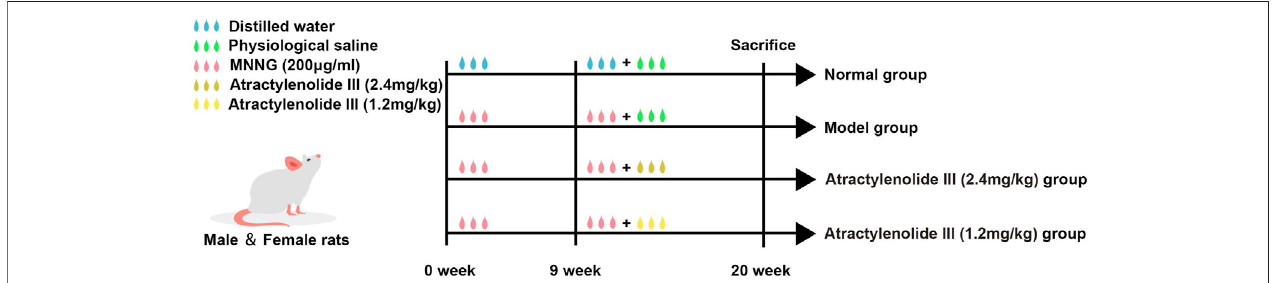
FIGURE 1 | Flowchart of experimental design. 1) Normal group (treated with distilled water and physiological saline, control group); 2) Model group (treated with MNNG and physiological saline); 3) Atractylenolide III (2.4 mg/kg) group (treated with MNNG and high dose AT-III); 4) Atractylenolide III (1.2 mg/kg) group (treated with MNNG and low dose AT-III). MMNG, N-methyl-N ′